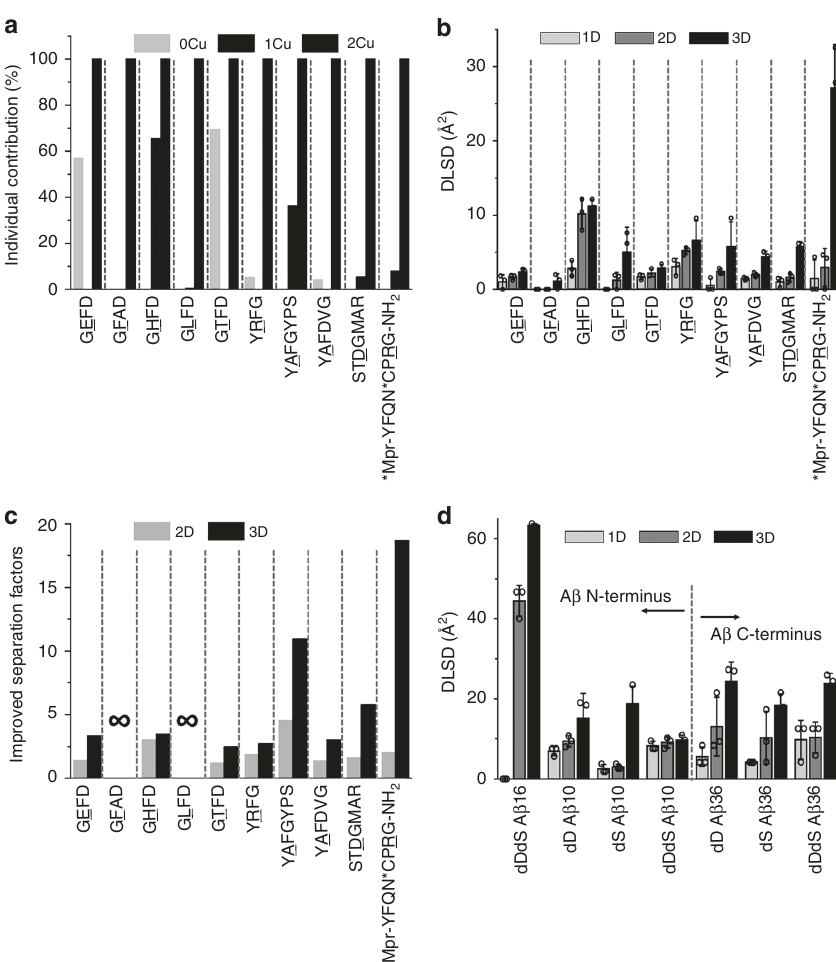
Fig. 3 Characterization of the separation ef fi ciency of iCAP. a Individual contribution ratio is calculated by normalizing the CCS differences of D/L-peptides (0Cu- and 1Cu-bound complexes) to 2Cu-bound complexes. In all cases, the individual contributions of 2Cu-bound complexes are thus de fi ned as 100%. Results indicate the necessity of employment of multidimensional separation. b DLSD values for a wide range of chiral neuropeptides under multidimensional conditions. c Improved separation factors for each DAACP group calculated through dividing the 2D-DLSD and 3D-DLSD values by 1D- DLSD. ∞ , unresolved peptides (GFAD/GLFD) are effectively separated with DLSD calculation even though they are not quanti fi able by using improved separation factor due to 1D-DLSDs for GFAD and GLFD being 0. d DLSD values for chiral A β fragments. Peptide groups are separated by green dashed lines. All error bars denote S.D.; n = 3 biologically independent samples. Box charts are shown with mean values. Source data are provided as a